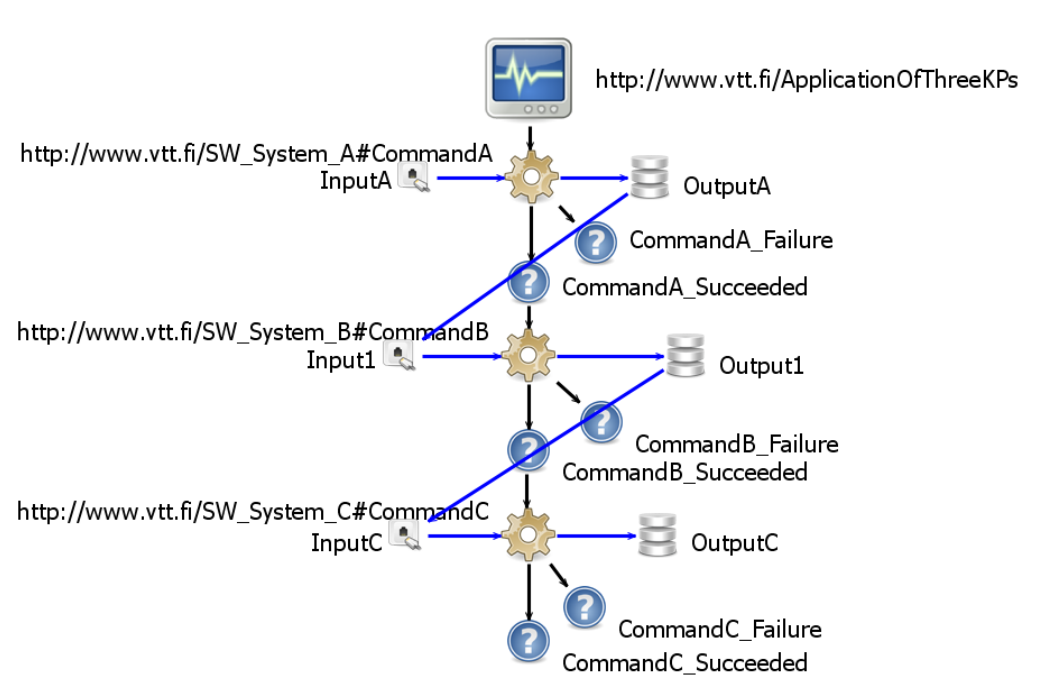
Figure 5. A cross-smart space application that uses the commands of S-APIs A, B, and